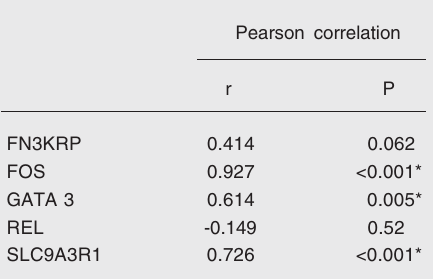
evaluated by cDNA microarray and quantitative